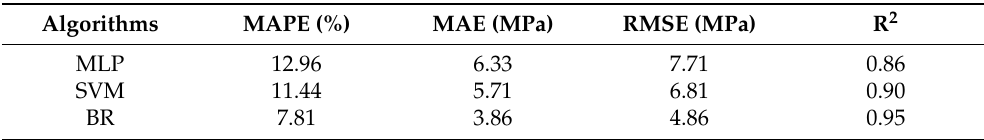
Table 2. Statistics derived from the employed